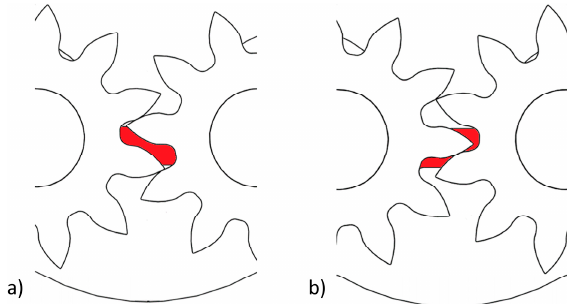
Figure 6. Engaging process compared to the relief groove shape: ( a ) the two pairs of teeth do not seal the relief groove with respect to the suction/discharge ports and ( b ) the teeth contact isolates the relief groove and seals the suction/discharge ports.